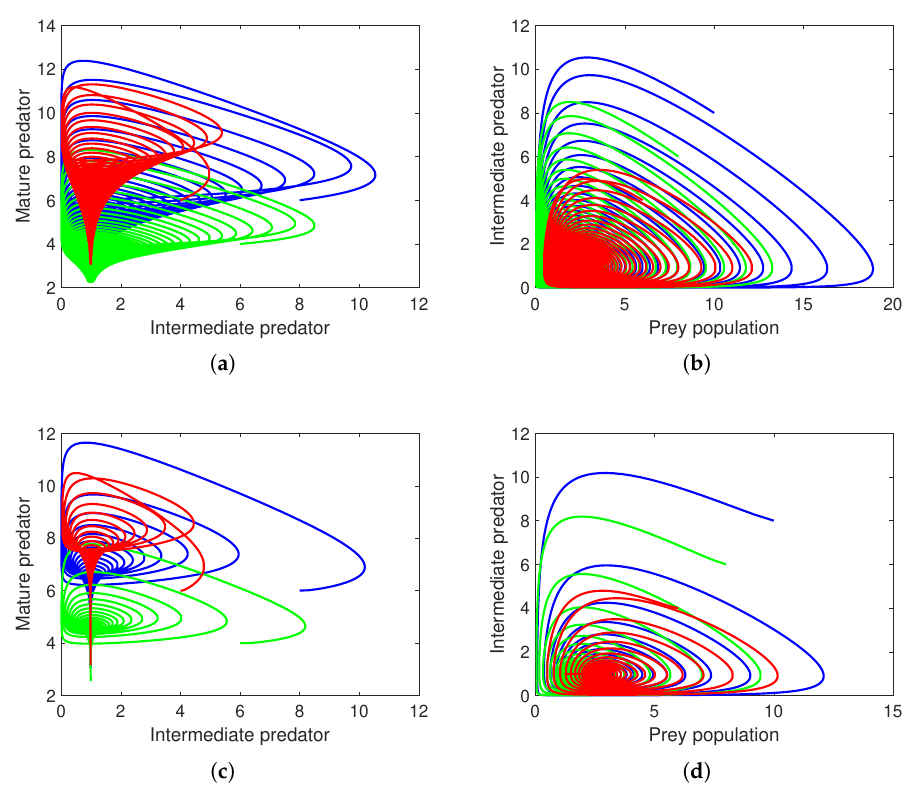
Figure 5. The 2D behavior of different phase planes of model (2) with different initial values. In Figure 6, the dynamical behavior of prey population, mature, and immature preda- tors, respectively. In Figure 6a,b, the blue, green, and red colors show the behavior of different populations with varying the parameter L . From Figure 6c,d, the blue, green, and red colors show the behavior of different populations with varying the parameter γ . Ac- cording to the simulations, the system exhibits a variety of oscillations and exhibits chaotic behavior at higher fractional orders, whereas, at lower fractional orders, the oscillations’ amplitudes diminish, and the system rapidly approaches equilibrium.